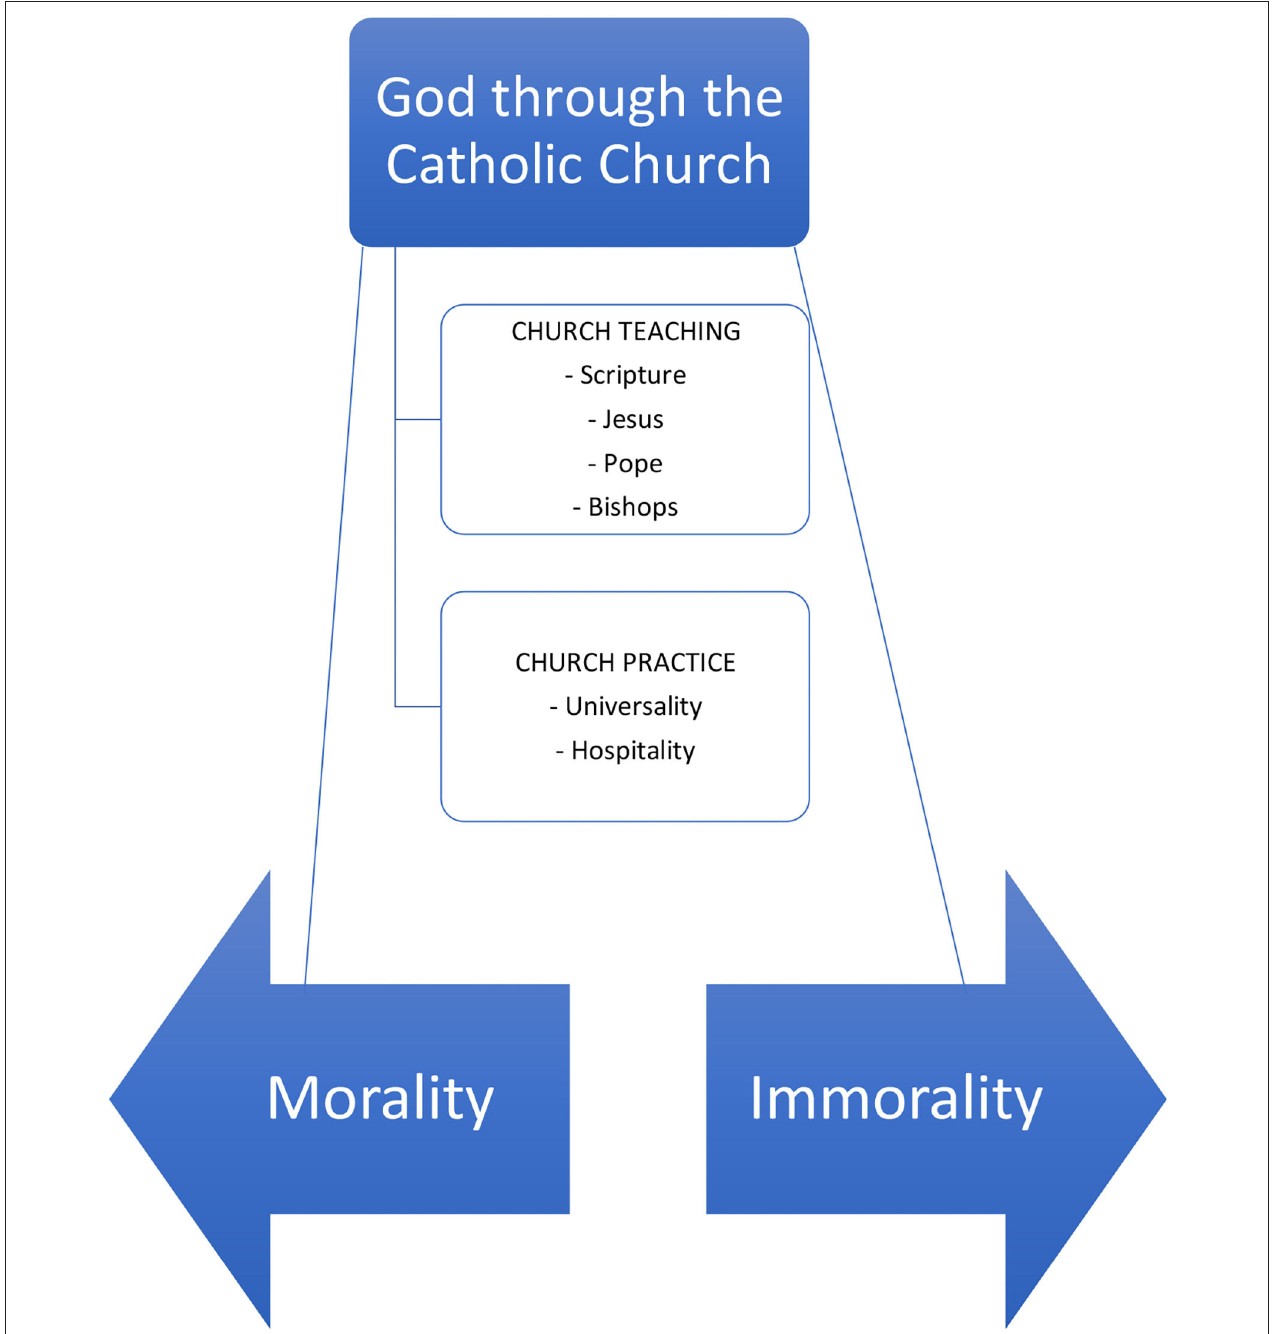
FIGURE 1 | The immigration agon and